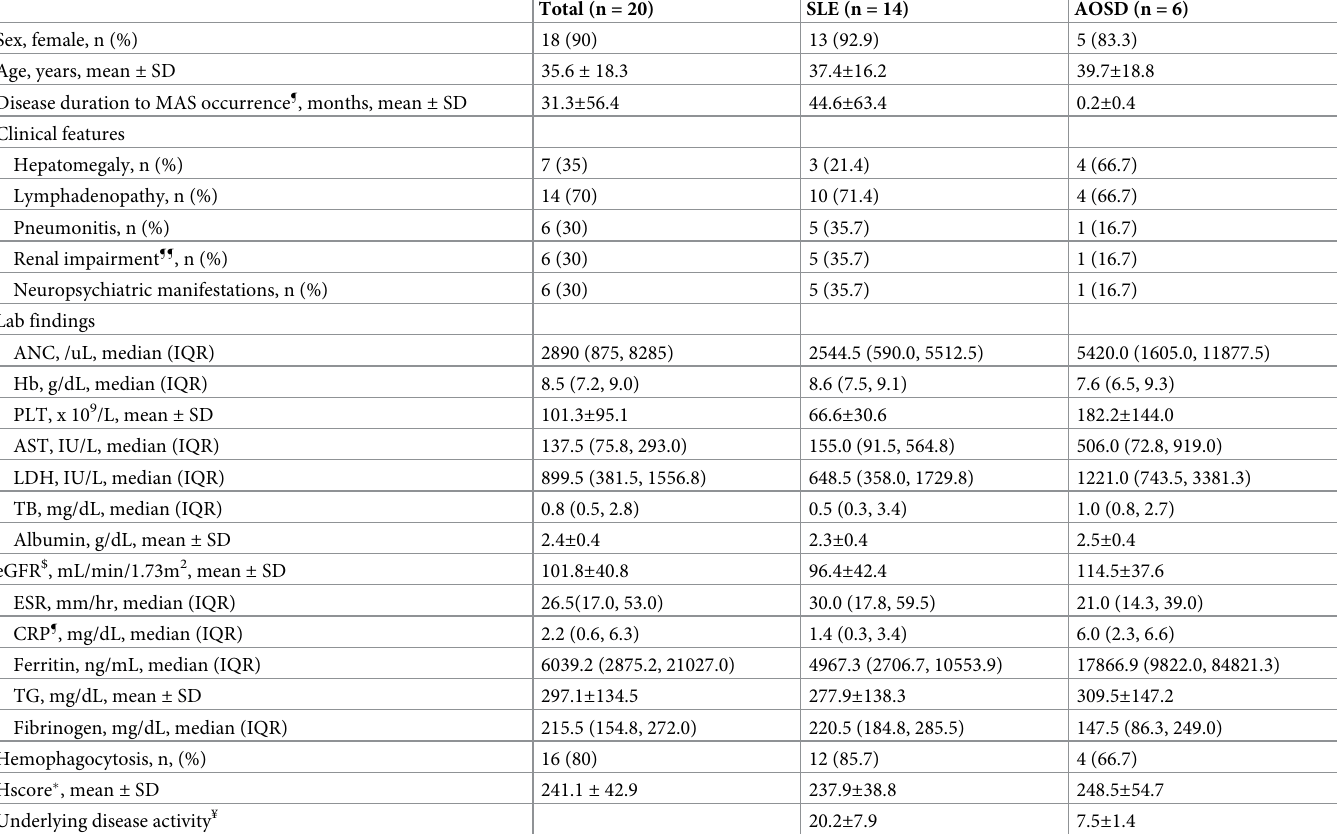
Table 2. Baseline characteristics of 20 patients with